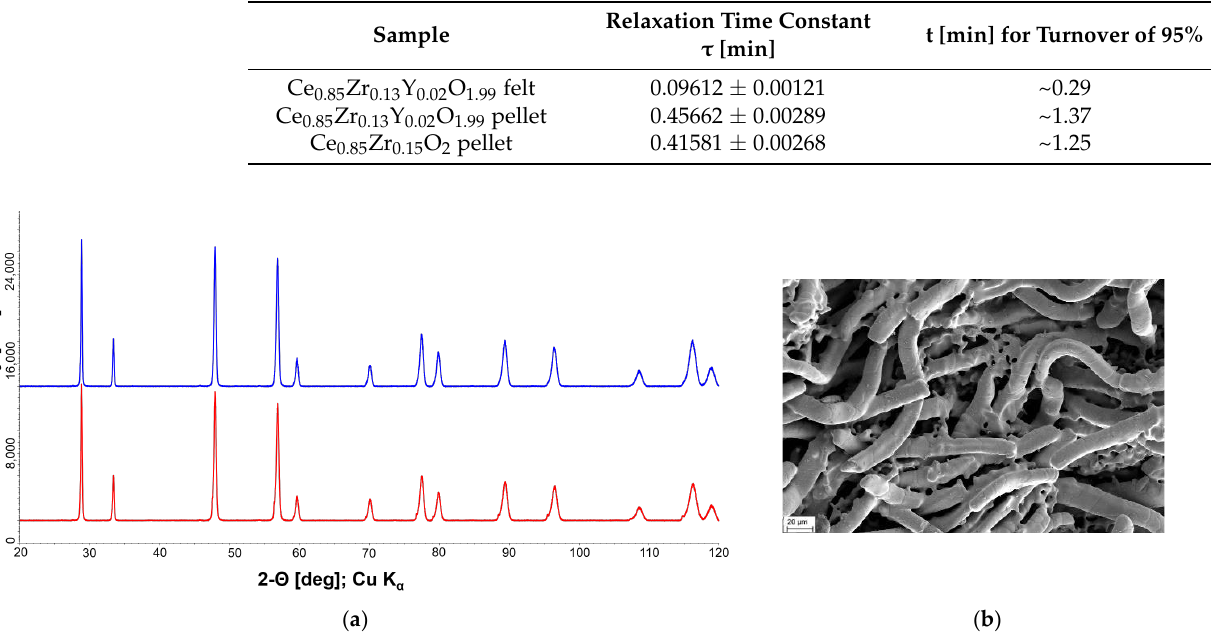
Figure 14. ( a ) XRD-profile of Ce 0.85 Zr 0.13 Y 0.02 O 1.99 felt before (red) and after cycling (blue). ( b ) SEM of Ce 0.85 Zr 0.13 Y 0.02 O 1.99 felt after